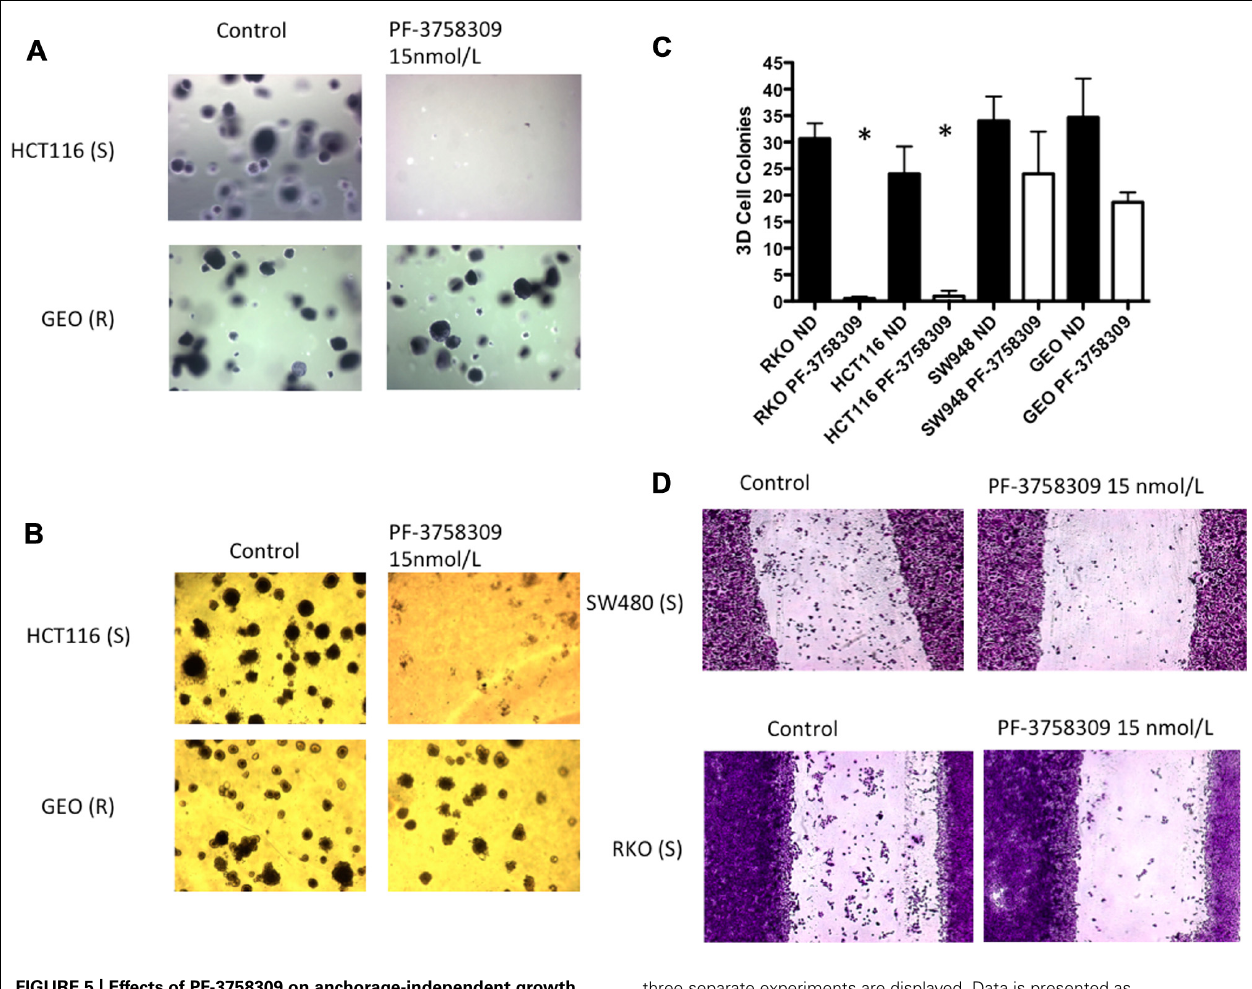
three separate experiments are displayed. Data is presented as mean ± SEM ( t -test: * p < 0.001). (D) RKO and SW480 were evaluated for their migratory phenotype in the presence of PF-3758309. Cells grown to 80% confluence were cleared with a scratch and migration was measured by the ability of cells to migrate into scratch after 48